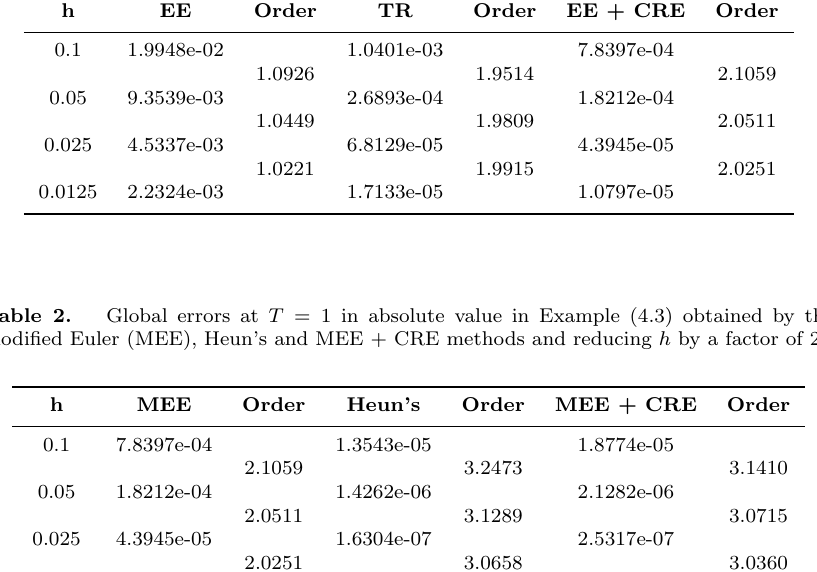
Table 1. Global errors at T = 1 in absolute value in Example (4.3) obtained by the EE, Trapezoidal (TR) and EE + CRE methods and reducing h by a factor of 2. h EE Order TR Order EE + CRE Order 0.1